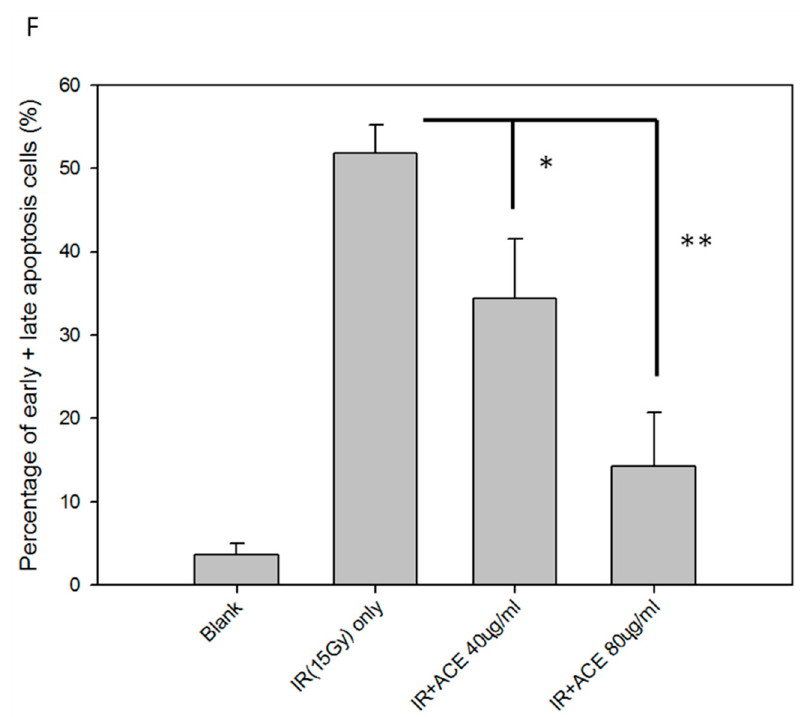
Figure 2. Protective effects of ACE against irradiation-induced apoptosis. CL48 cells were pre-treated with various concentrations of ACE for 16 h followed by irradiation at 15 Gy. Cells were harvested 48 h later for determination of caspase-3 activity ( A ), caspase-8 activity ( B ), and caspase-9 activity ( C ). The fold differences of the three caspase activities relative to individual control groups were also presented ( D ). For apoptosis analysis, cells were harvested 30 h after treatment followed by staining with PI and Annexin V ( E ). Results are representative of three independent experiments. The statistical analysis of the percentages of early plus late apoptotic cells ( F ). *, p < 0.05; **, p < 0.01, as compared with the irradiated ACE 0 µ g/mL control group.